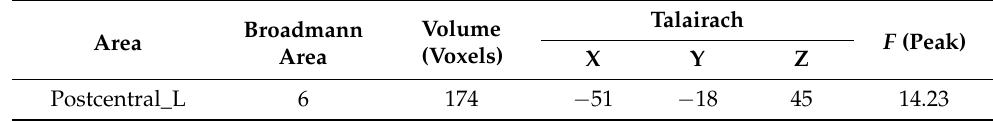
Table 6. Regional information of changed FC in repeat ANOVA.